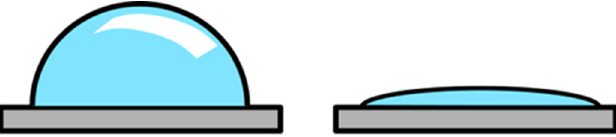
Figure 4. Plasma treatment of seeds decreases water contact angle. Water contact angle of untreated surface on the left, and decreased water contact angle of the surface after plasma pre-treatment on the right.